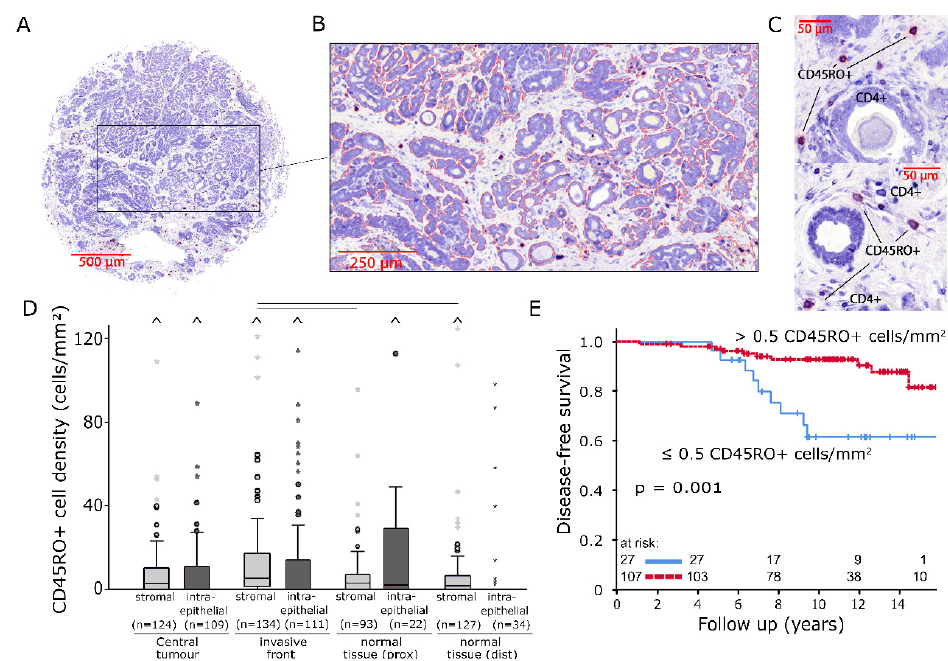
Figure 3. ( A ) Image of a representative breast cancer tissue microarray core double-stained for CD45RO/CD4 (200× magnification). ( B ) Intraepithelial tumour compartment marked with image analysis software. ( C ) Representative examples of CD45RO+ (violet) and CD4+ (blue) tumour-infiltrating inflammatory cells (TIICs). ( D ) Stromal and intraepithelial cell density distributions of CD45RO+ TIICs in samples from four different locations. The central line represents median values, while the box is indicative of the interquartile range (IQR). Whiskers represent 1.5× IQR or minimum/maximum. Outliers are indicated by points (up to 3× IQR) or asterisks (>3 IQR). Outliers not visible in this diagram are depicted as a caret. Black bars signify p < 0.05 in Student’s t test. (E) Disease-free survival analysed with the Kaplan–Meier method and log-rank test according to CD45RO+ TIIC densities in the stromal compartment of invasive front samples. CD4+ T-helper cells were the most frequently registered TIICs in this study (Figure 4A), with